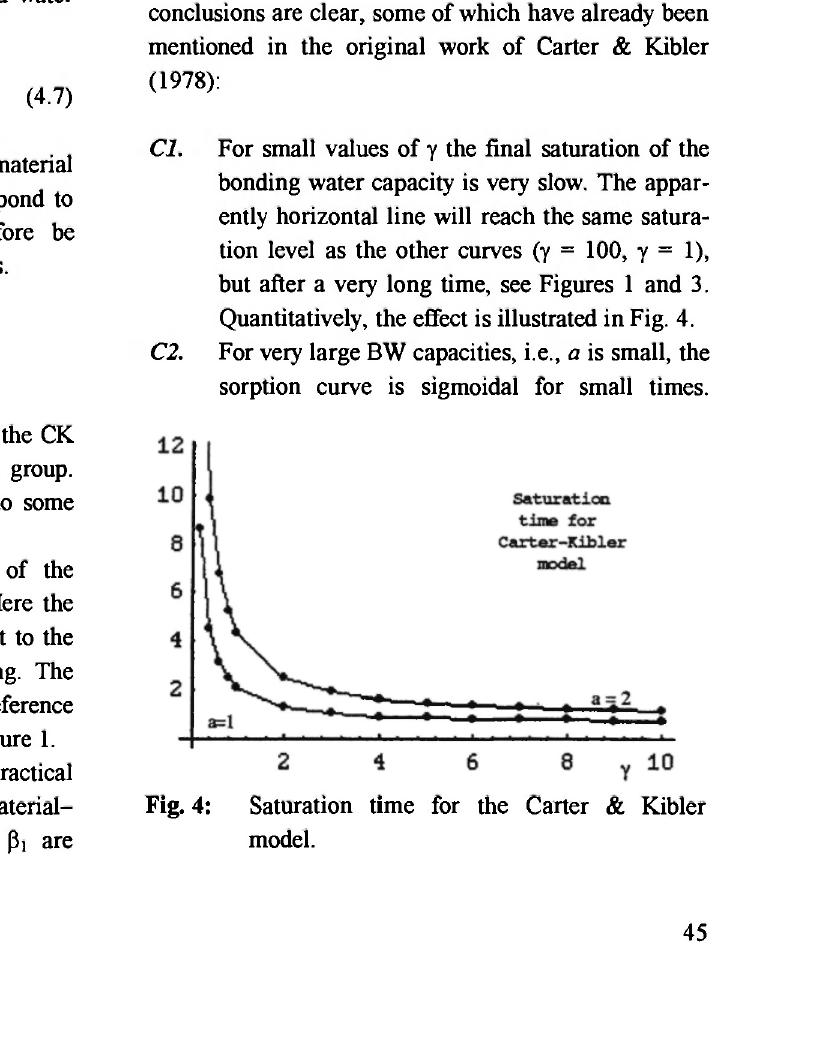
Fig. 2: The surface concentration, BW equilibrium concentration and water equilibrium concentration as a function of the external pressure for Αι = 0.1, d = 50, X = 1.